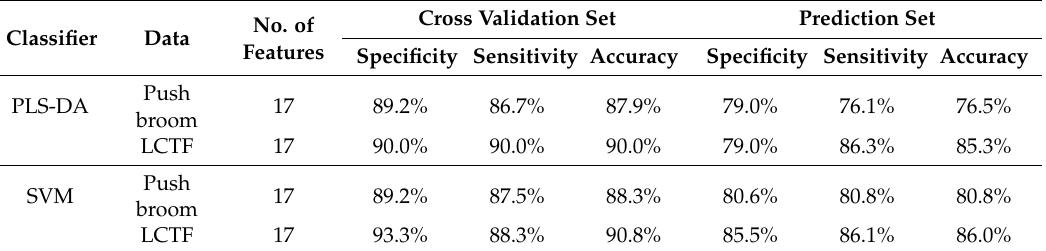
Table 1. Classification results of PLS-DA and SVM models distinguishing between bruised and healthy samples based on the effective features selected from push broom based and LCTF based HSI separately.